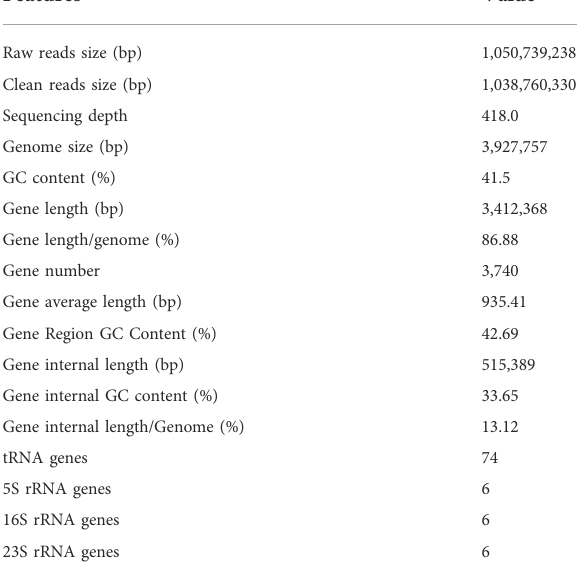
TABLE 1 General genome features of Acinetobacter sp.